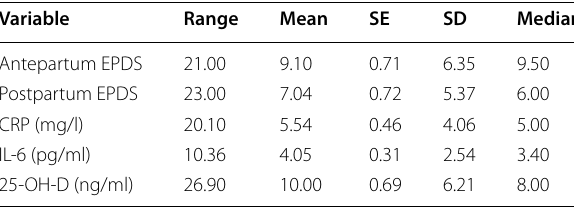
Table 2 Descriptive statistics of EPDS and biomarkers